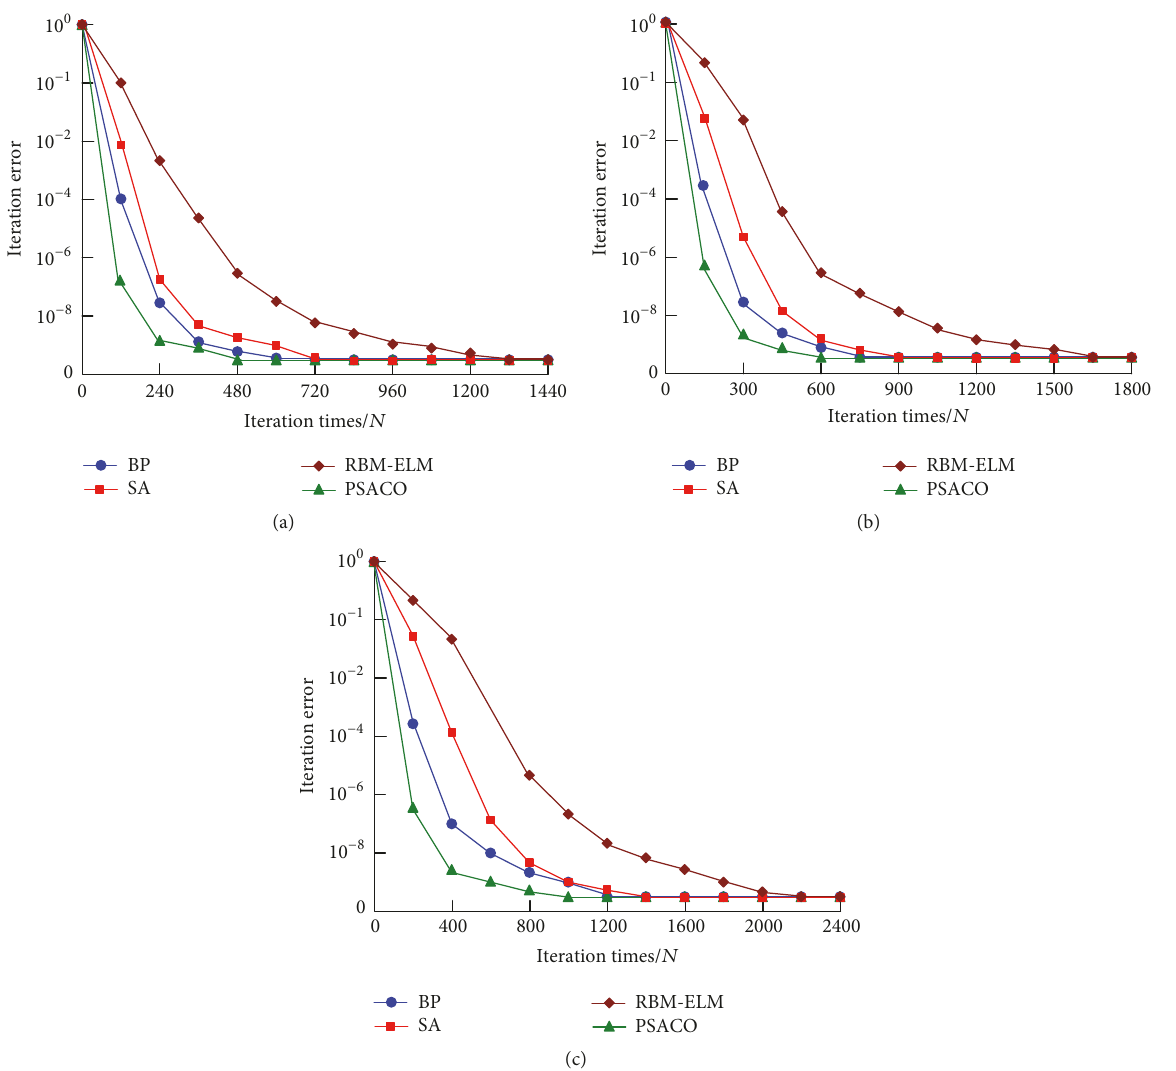
Figure 5: Clustering comparative results with the BP, SA, and RBM-ELM algorithms for CNIS-II: (a) original sample, convergence iteration times: 405, 501, 698, 1323; (b) damaged sample, convergence iteration times: 575, 622, 733, 1655; (c) transformed sample, convergence iteration times: 790, 1031, 1195,